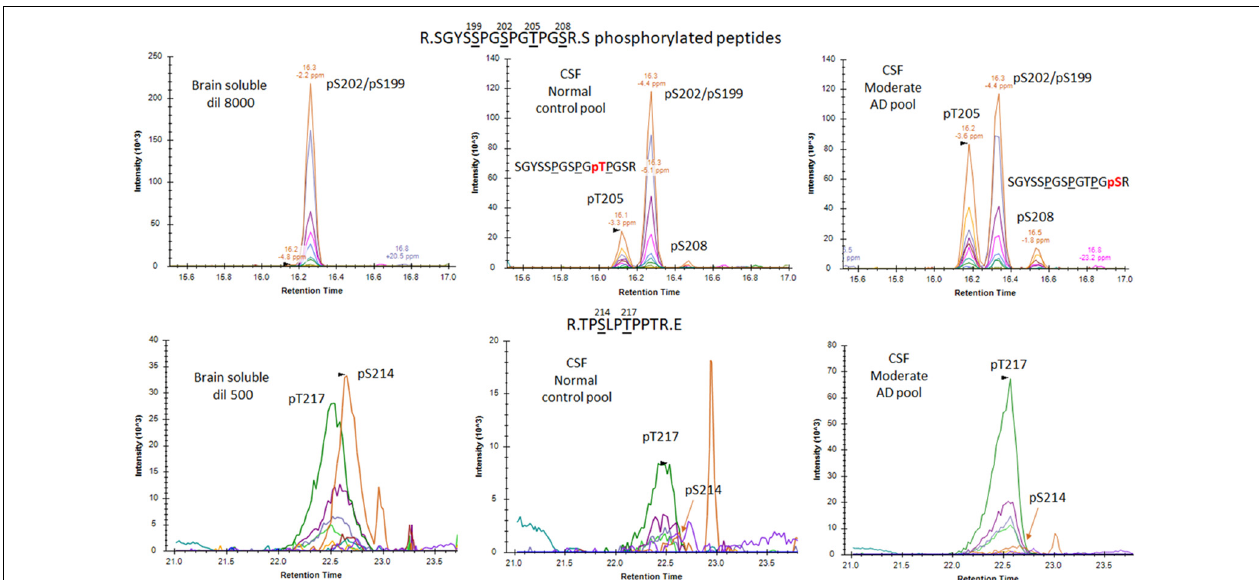
FIGURE 8 | Phosphorylated peptide profiles from tau sequences 195–209 and 212–221 are variable between the soluble brain fraction, normal cerebrospinal fluid (CSF), and Alzheimer’s disease (AD) CSF tau protein. Brain soluble tau extracts are diluted as indicated to approximately match corresponding CSF tau level. Phosphorylated peptides on 195–209: in brain lysate, one signal corresponding to the co-elution of two phosphorylated peptides pS199 and pS202 is observed. In CSF, two additional signals are observed. Fragment analysis allowed the assignment of the signal on left to pT205. In AD CSF, the two signals are increased allowing the identification of specific fragments assigning the signal on the right to pS208. Phosphorylated peptides on 212–221: two signals with similar MS intensities corresponding to pT217 and pS214 are identified in brain lysate. In CSF, the signal corresponding to pT217 is the most intense while pS214 is close to the limit of detection, indicating a dramatic change in their relative abundance in comparison to the brain extract. In AD CSF, pT217 is significantly increased due to specific